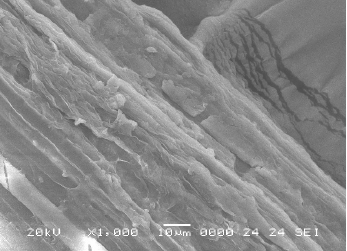
Figure 10. SEM micrograph of MLP (magnification: 1000 x ) before dye